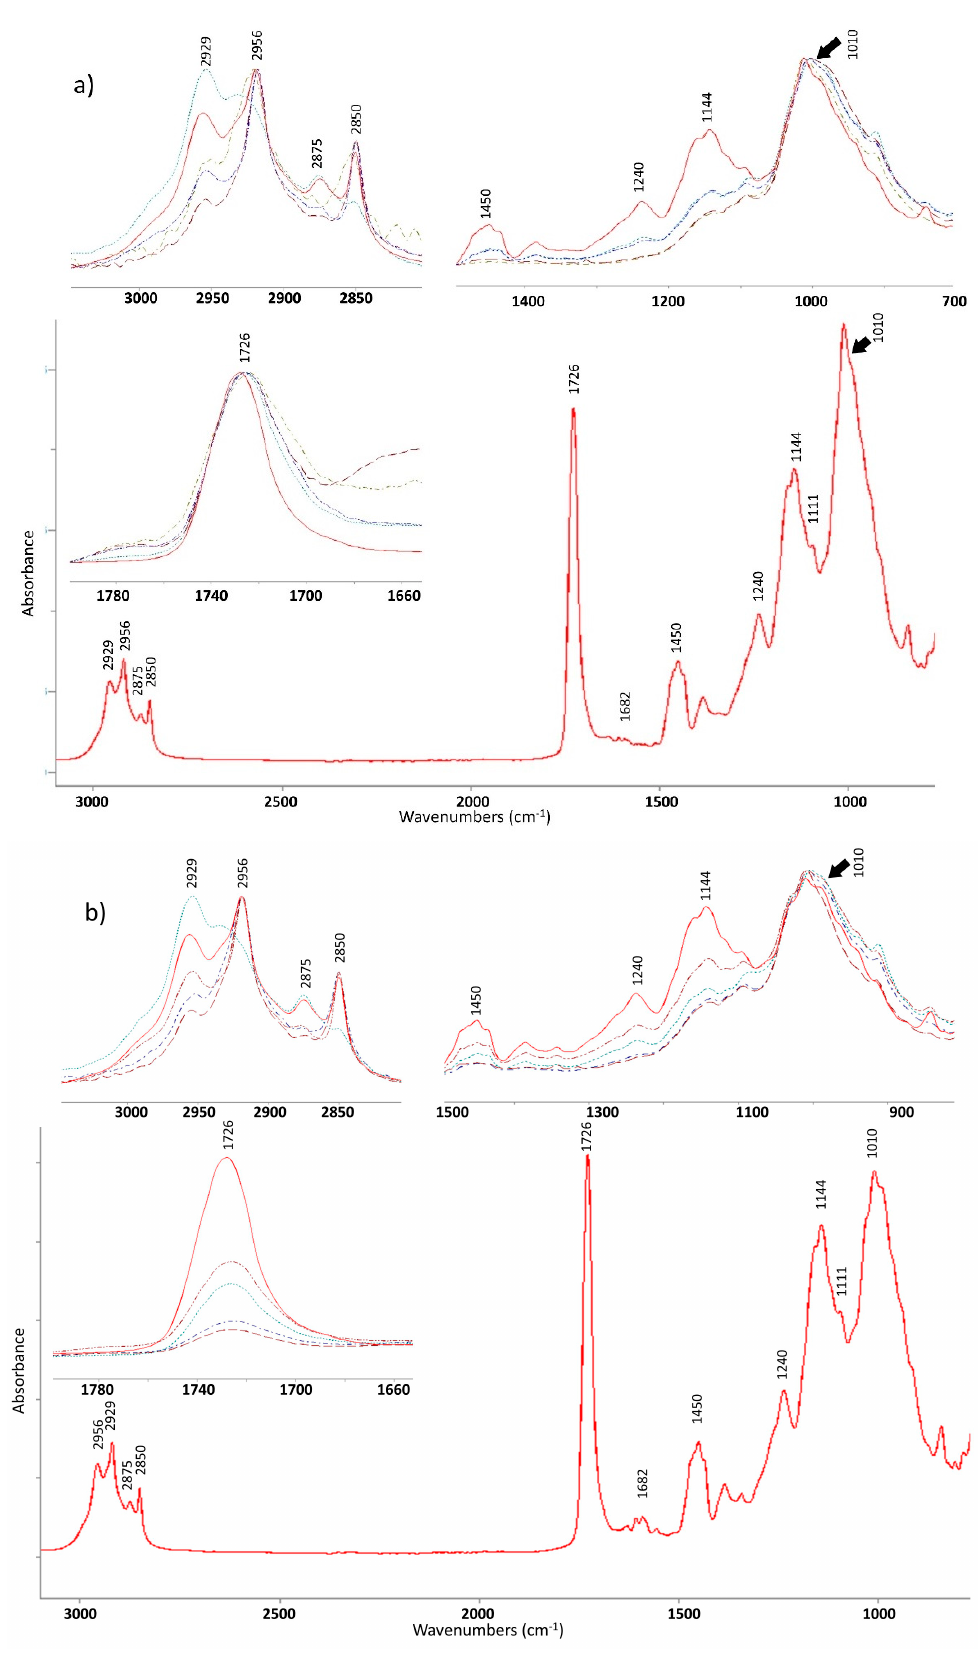
Figure 1. FTIR-ATR spectra of ( a ) Paint 1 and ( b ) Paint 2. Control (solid line), QUV (dash line), Quebec (short dash line), Arizona (dash-pointed line), and Florida (dash double pointed line). Table 3. Identification of most important peaks in FTIR-ATR spectrum of acrylic paint [11,28].